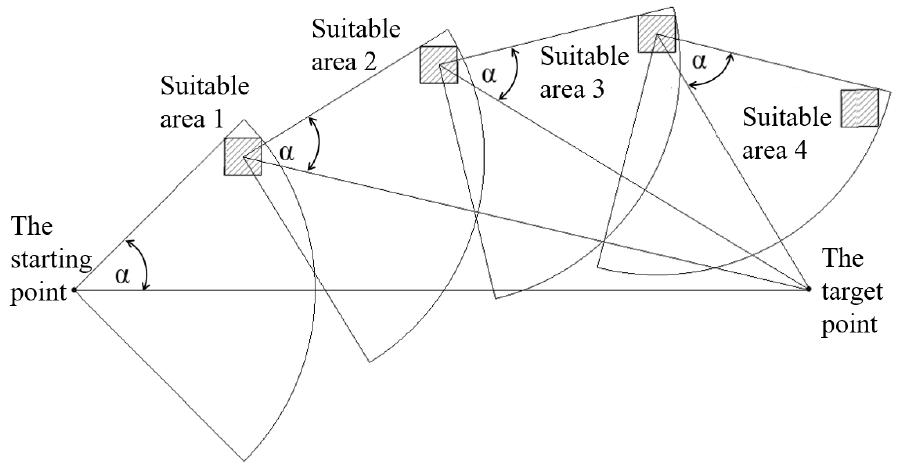
Figure 9. TAN-suitable area obtained will appear behind the target